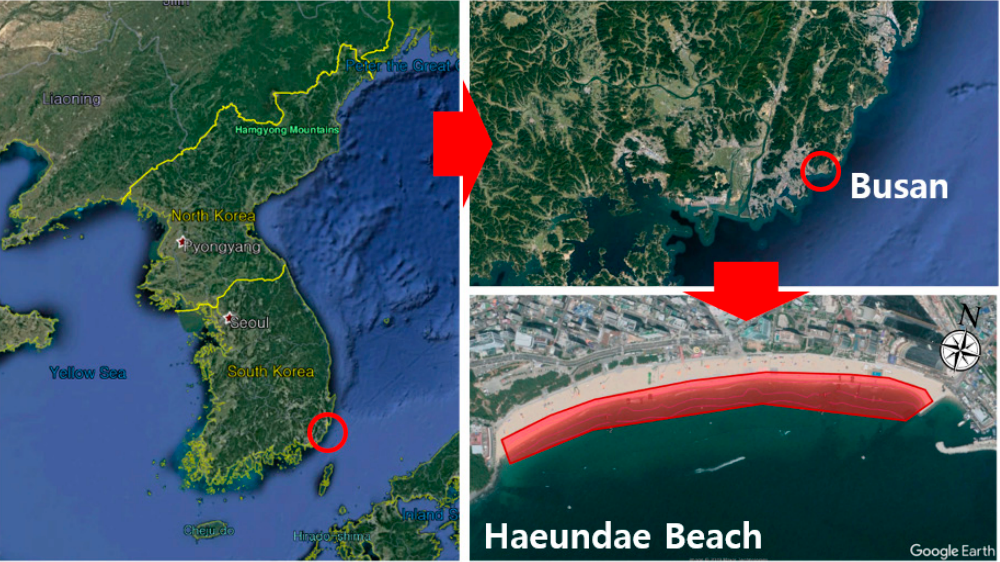
Figure 1. The study location of Haeundae Beach in Busan, South Korea (images from Google Earth).